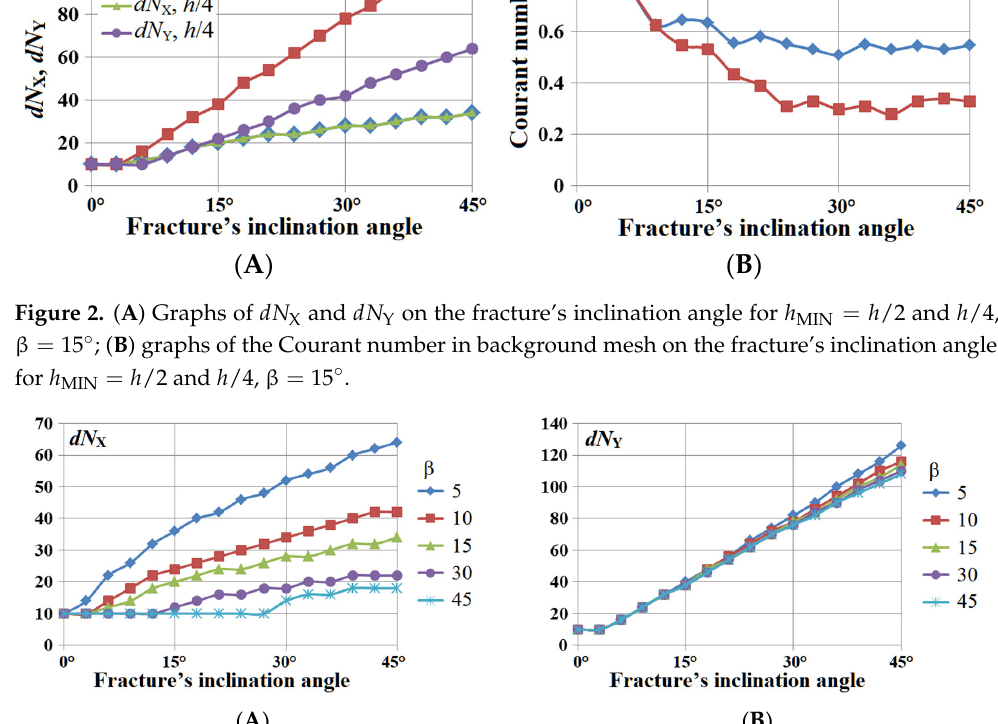
Figure 3. ( A ) Graphs of dN X on the fracture’s inclination angle β = 5 ◦ , 10 ◦ , 15 ◦ , 30 ◦ , 45 ◦ , h MIN = h /2; ( B ) graphs of dN Y on the fracture’s inclination angle for β = 5 ◦ , 10 ◦ , 15 ◦ , 30 ◦ , 45 ◦ , h MIN = h /2. Note that in Figures 2A and 3 minimum dN X and dN Y values are 10.